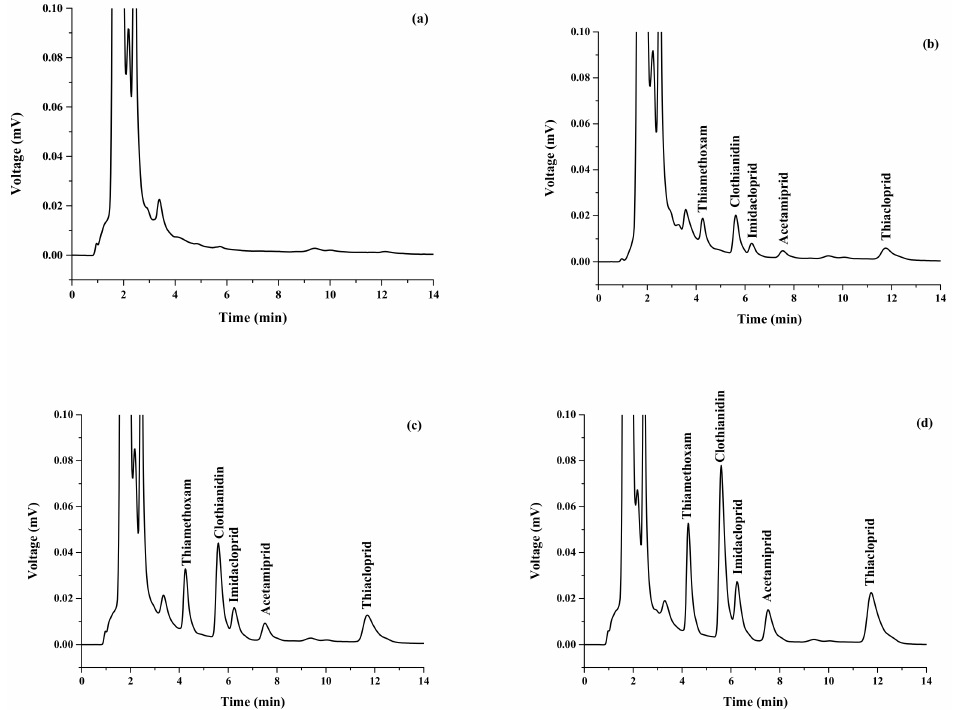
Figure 7. Chromatograms of ( a ) longan sample, ( b ) longan sample spiked with 100 ng mL − 1 of each neonicotinoid, ( c ) longan sample spiked with 250 ng mL − 1 of each neonicotinoid, and ( d ) longan sample spiked with 500 ng mL − 1 of each